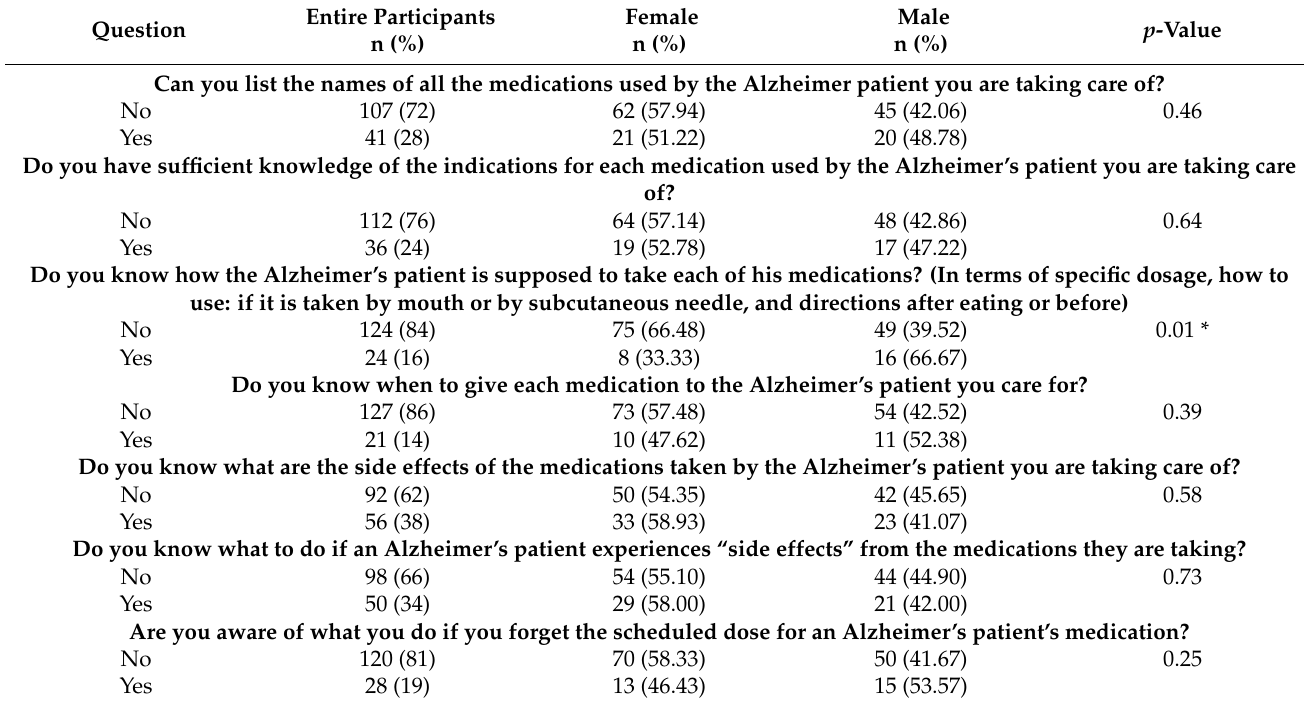
Table 4. Caregiver Knowledge Regarding Medications for Alzheimer’s Patients.